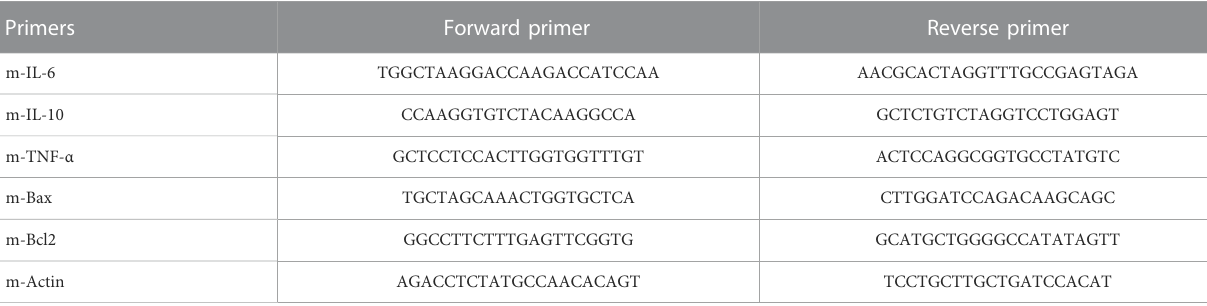
TABLE 1 Primer sequences for